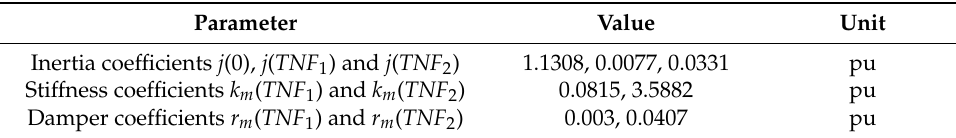
Table 2. Turbine-generator (TG) unit modal